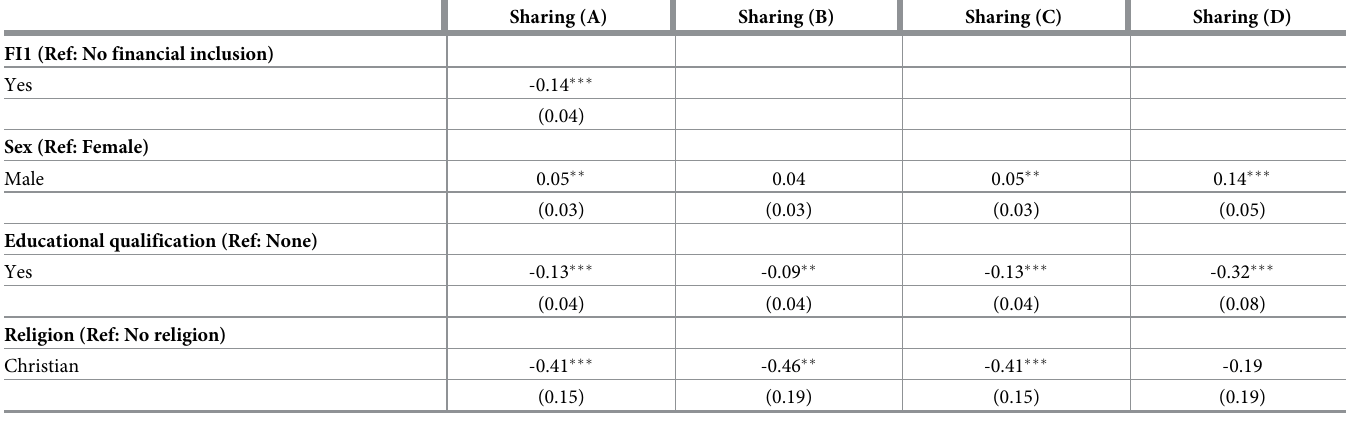
Table A2. Probit regressions: Effect of financial inclusion on sharing of toilet facilities (robustness